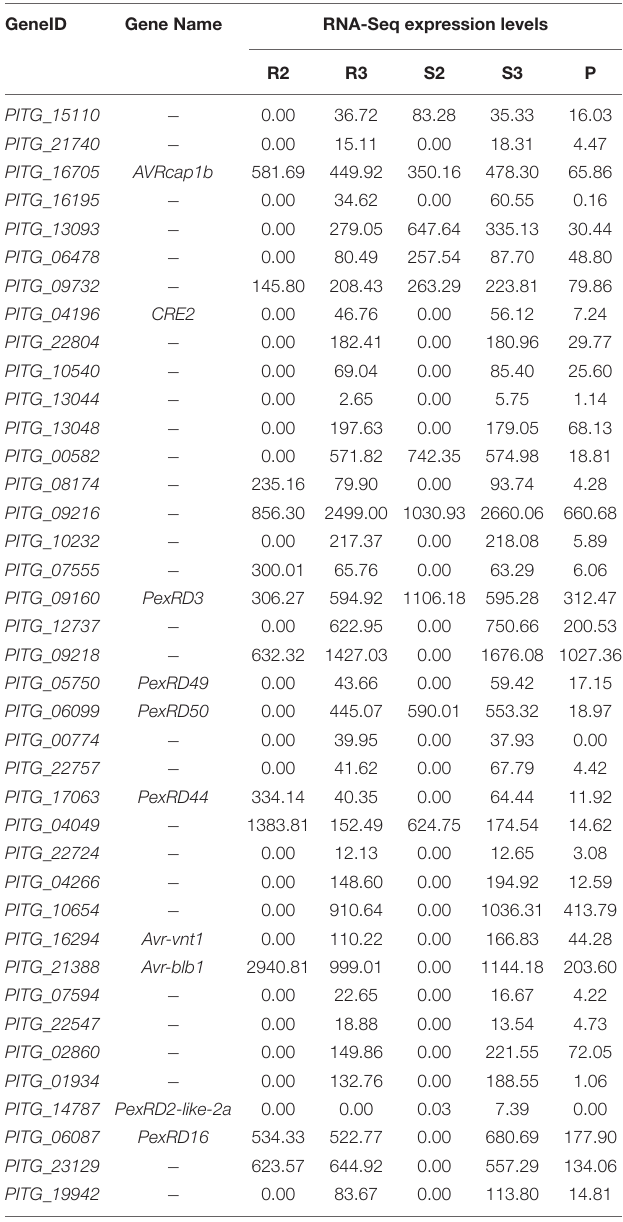
TABLE 2 | Upregulated Arg-X-Leu-Arg ( RXLR ) genes identified by microarray (Haas et al., 2009) and RNA sequencing (RNA-seq) during the